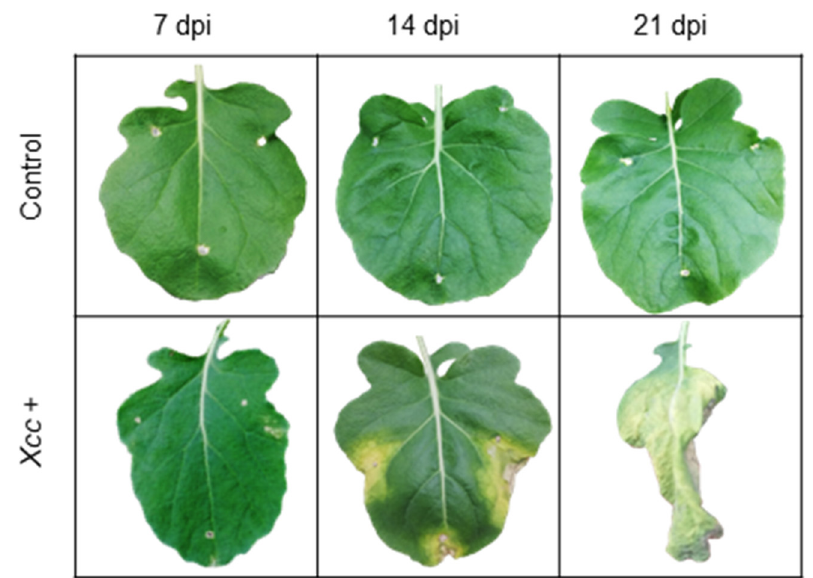
Figure 2. V-shaped necrotic lesions appeared in Brassica oleracea leaves when infected with bacte- rium Xanthomonas campestris pv. campestris . The picture shows a leaf’s appearance at 7, 14, and 21 days post inoculation (dpi), and a control leaf on the same